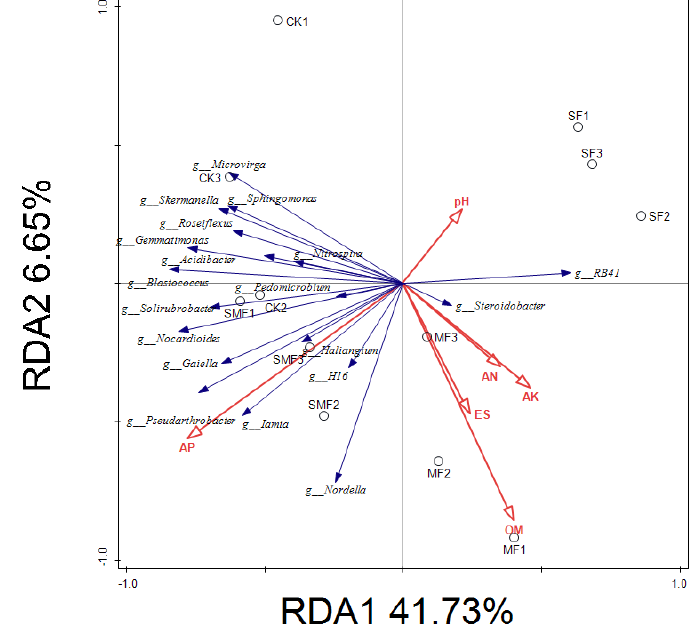
Figure 7. Redundancy analysis (RDA) of bacterial genera in soil and soil physicochemical properties: bacteria included top 20 genera; AP, AN, AK, ES, OM, and AP represented available phosphorus, alkali-hydrolyzable nitrogen, available potassium, available silicon, and organic matter, respectively.